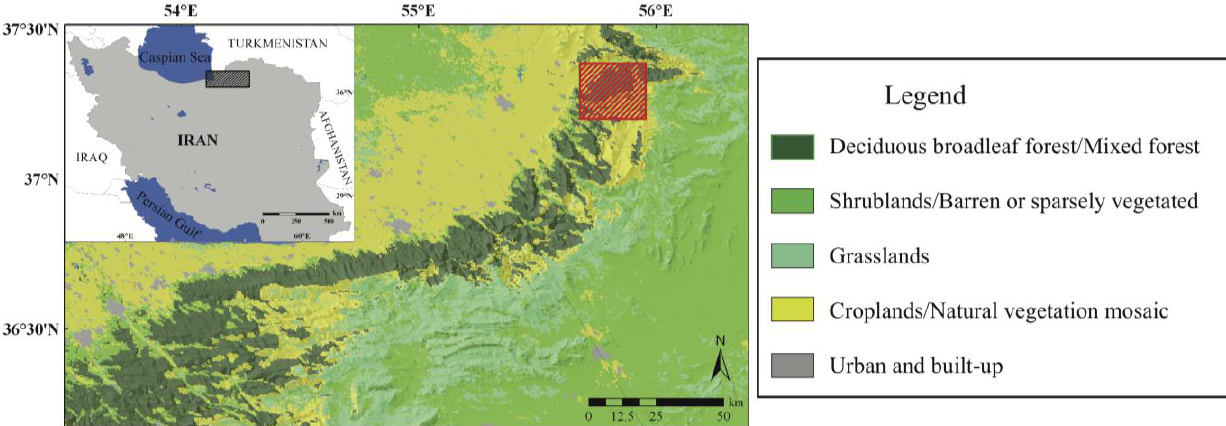
Figure 1. Location of the study area (red rectangle) in northern Iran. The land cover map is reclassified from 500 m MODIS land cover